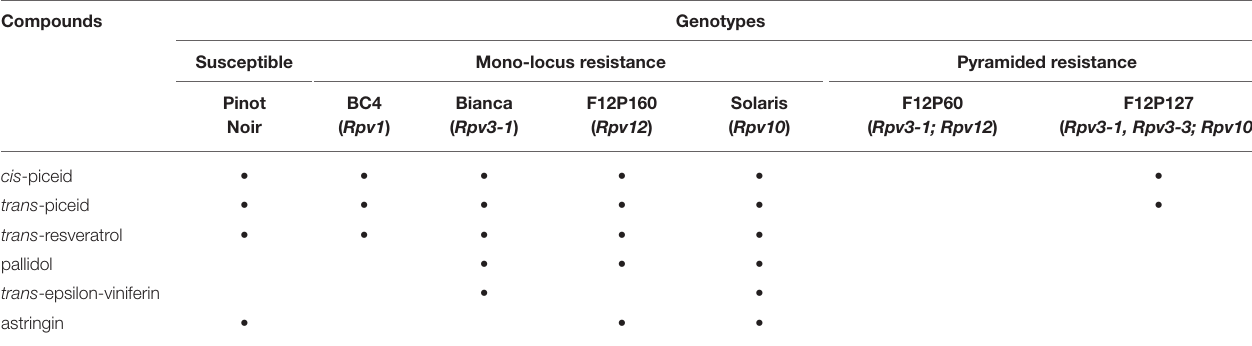
TABLE 3 | Potential biomarkers among stilbenes and stilbenoids as identified by the selection criterion.